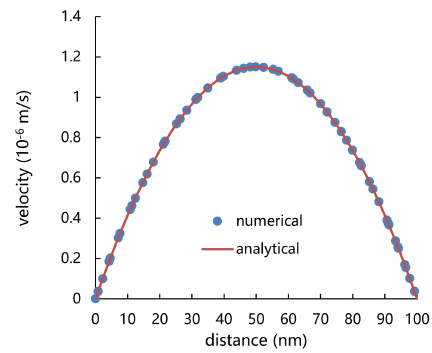
Figure 7. Comparison of velocity